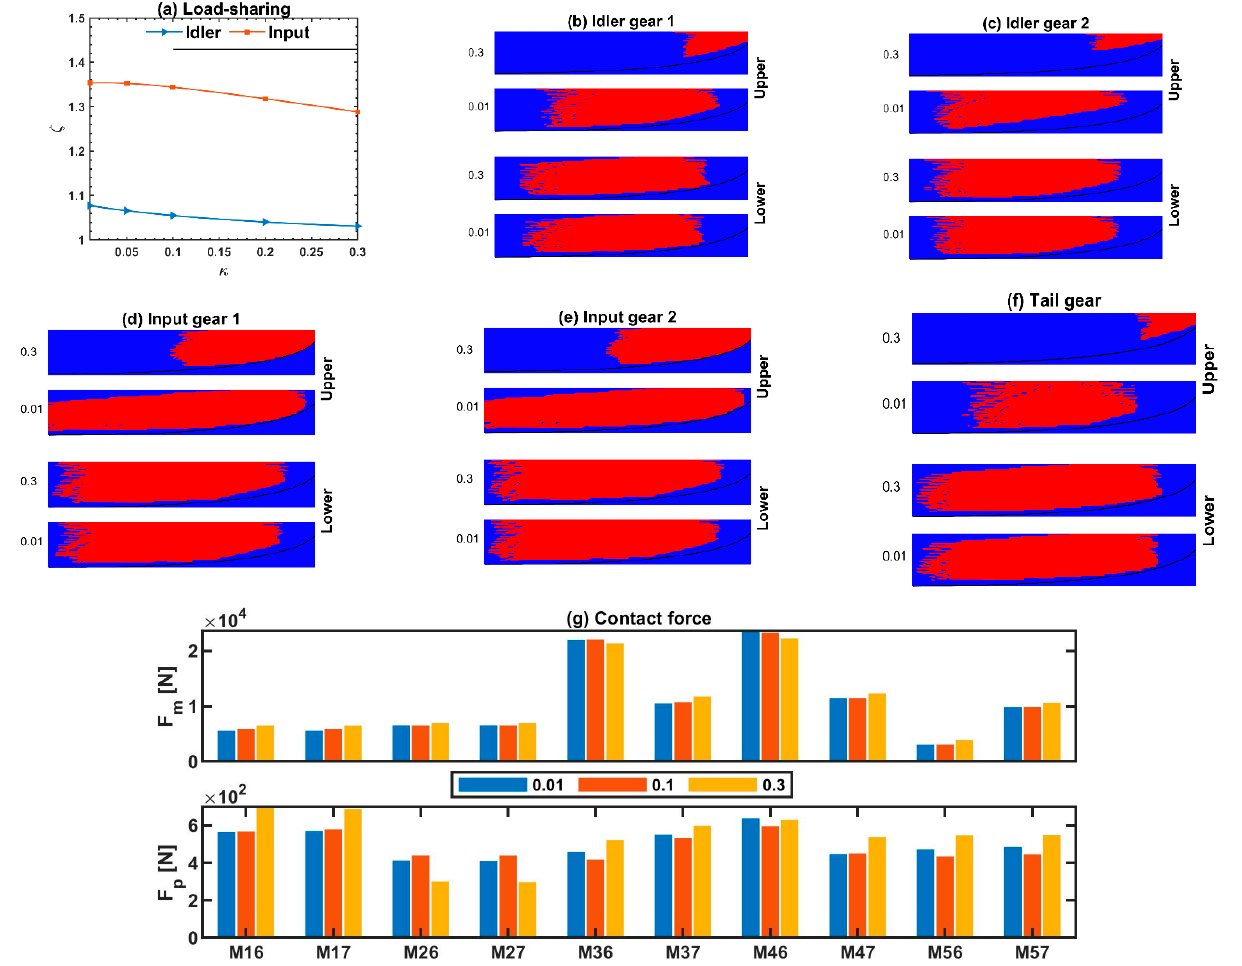
Figure 16. Influence of the axial installation error of the upper face gear on the load-sharing and contact characteristics.